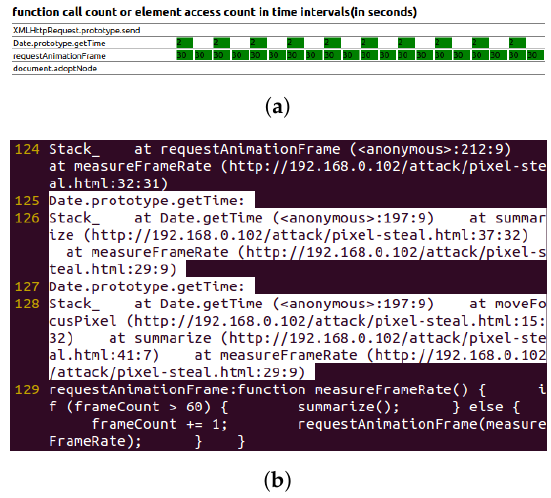
Figure 9. Pixel-based timing probing attack. ( a ) Real-time function call and element access chart; ( b ) behavior log (attack pattern is